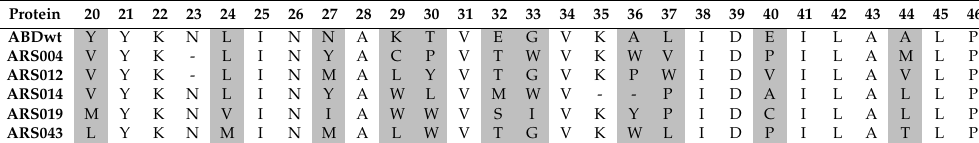
Figure 4. ARS ligands compete with IL-17A cytokine for binding to the human IL-17RA-IgG receptor chimera. The IL-17RA-IgG chimera was immobilized on an ELISA plate and serially diluted inhibitory His 6 -ARS-TolA-AVI ligands were used to compete for binding with 10 nM IL-17A. Bound IL-17A was detected with anti-IL-17A polyclonal antibody in combination with secondary anti-IgG-HRP conjugate. His 6 -ABDwt-TolA-AVI served as a negative control. Error bars represent standard deviations (SDs). Protein sequences of the five ARS protein variants that bound to the soluble IL-17 receptor chimera and exhibited a blocking potential are presented in Table 1. Table 1. Sequence comparison of the ARS binders. The non-mutated ABDwt was aligned with the randomized part of the ARS binders selected by ribosome display. Grey boxes indicate the 11 positions at which the residues of albumin-binding domain (ABD) (aa 20–46) were randomized. The non-randomized N-terminal part of ABD (aa 1–19) contain sequence LAEAKVLANRELDKYGVSD.